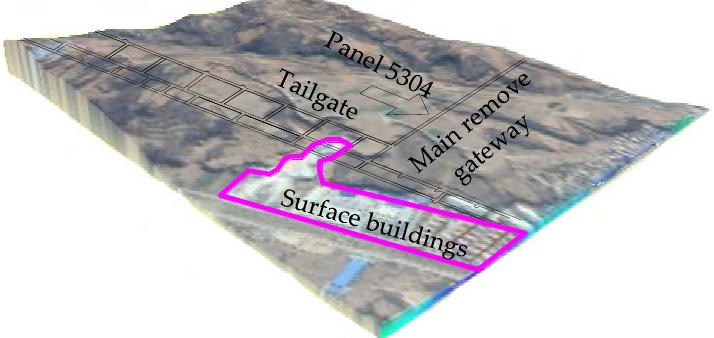
Figure 12. Surface buildings besides the panel 5304.